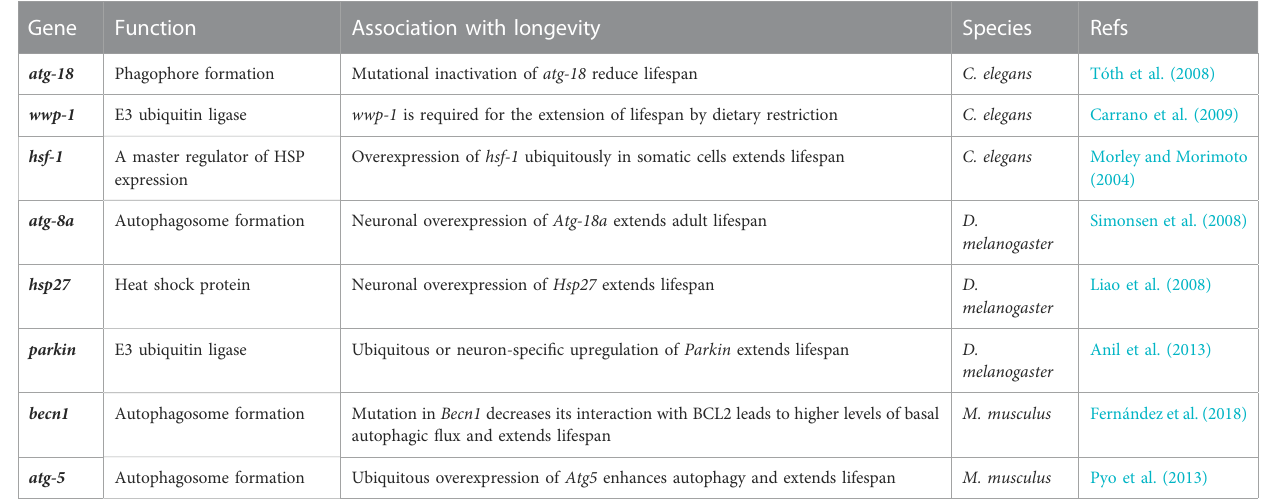
TABLE 1 Examples of proteostasis-related genes linked to organismal longevity. (All gene names were in lower case and only one representative study for each gene was listed here). Gene